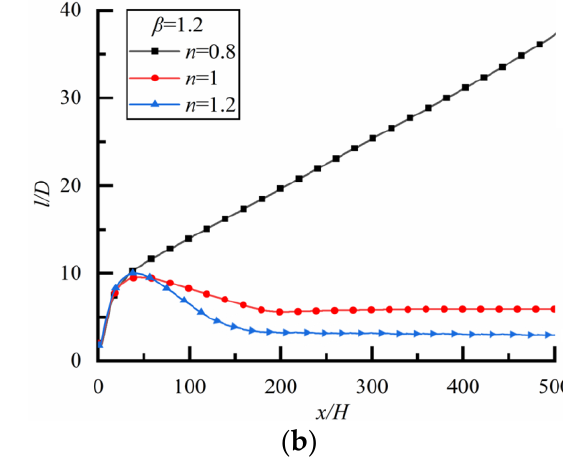
Figure 6. Changes of l/D along flow direction for different n ( Re =20). ( a ) β =0.5, ( b ) β =1.2.